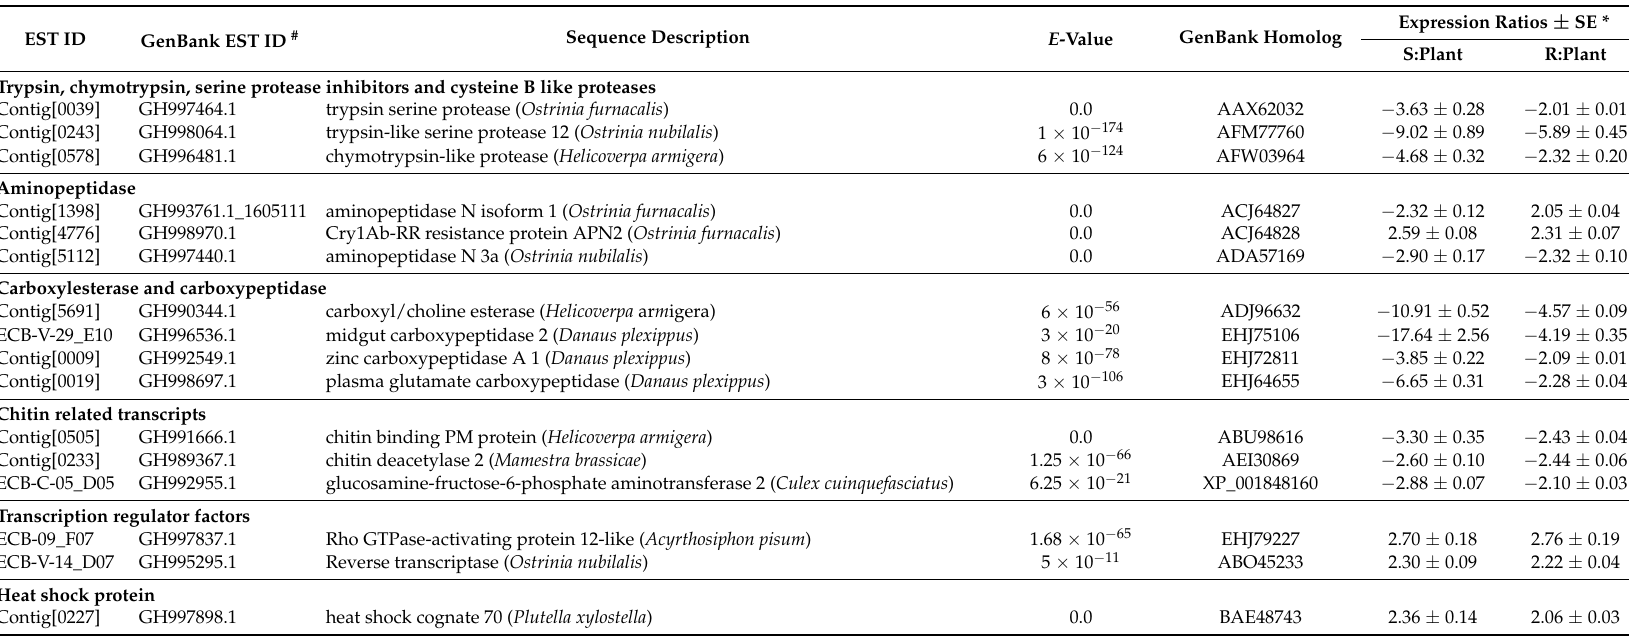
Table 2. List of gut genes in S- and R-strain larvae of O. nubilalis with a significantly differential expression after fed transgenic Cry1Ab as compared with those fed non-transgenic (control) corn leaves for 6